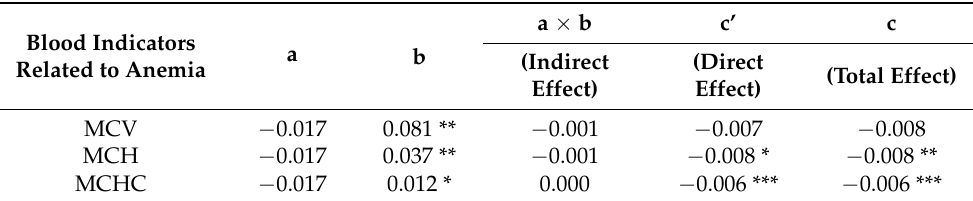
Table 4. Mediation analysis of baseline study particulate matter (gravimetric PM10) exposure for blood indicators related to